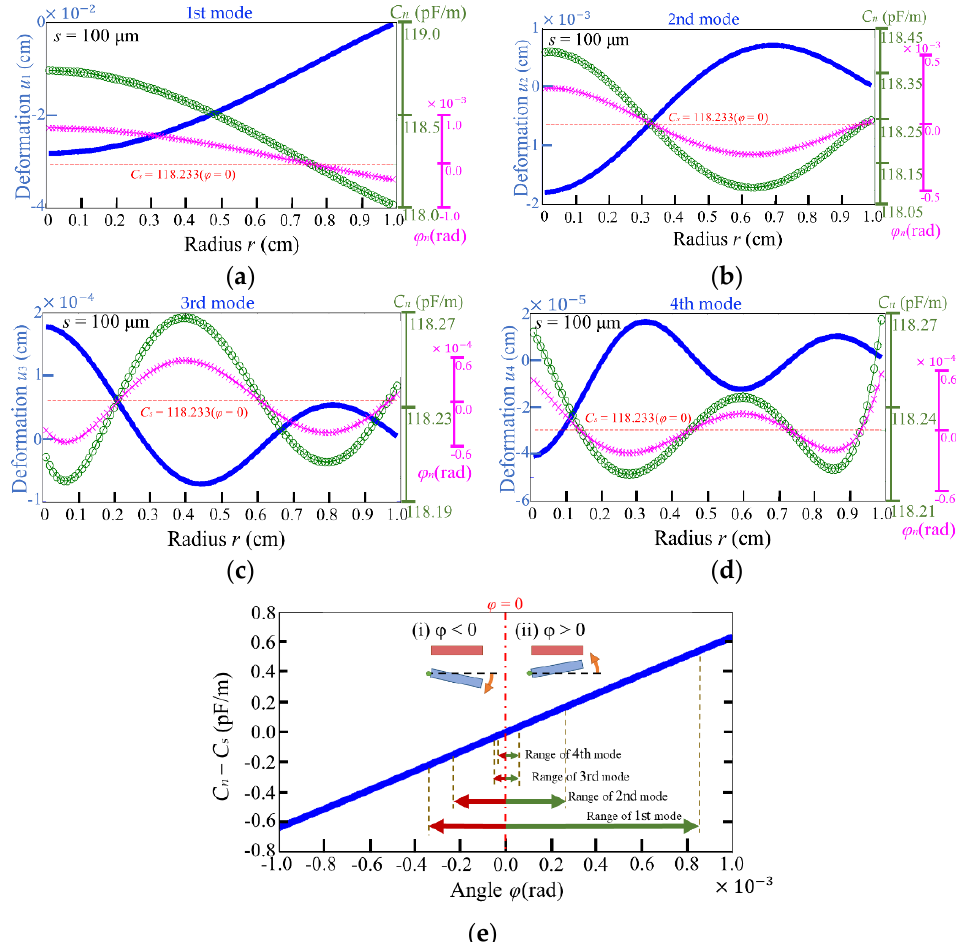
Figure 6. The membranous deformation u m (blue), the n -th angle φ n (pink) and capacitance (green) per unit longitudinal length C n ( C in + C out ) along the radius of the membrane in various modes: ( a ) 1st mode, ( b ) 2nd mode, ( c ) 3rd mode, and ( d ) 4th mode. C s = 118.233 pF/m means the capacitance before vibration. ( e ) The plot of ( C n − C s ) vs. angle of electrode.